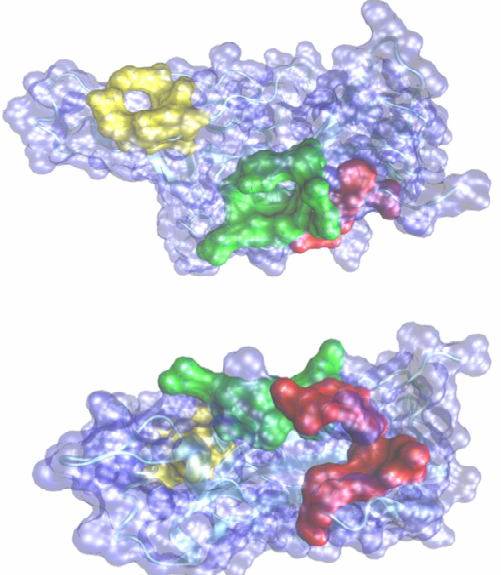
Figure 1. Predicted pockets in two different perspectives of views of the representation of the surface of spike fragment with the three pockets as indicated in Table 1. Pocket 1 in red, Pocket 2 in yellow and pocket 3 in green.